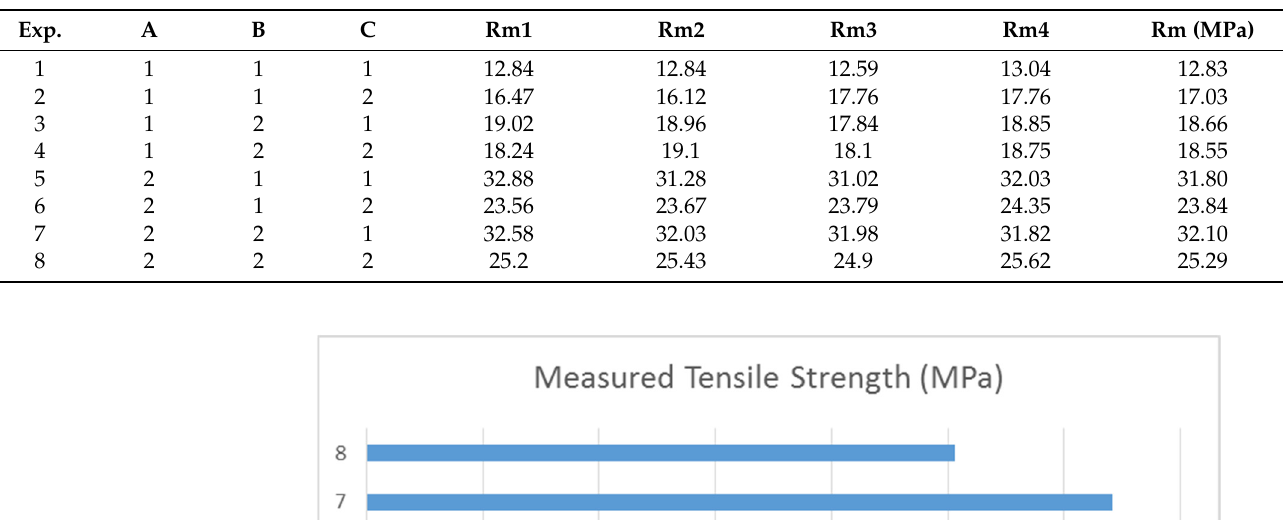
Table 5. Measured values of Tensile Strength.